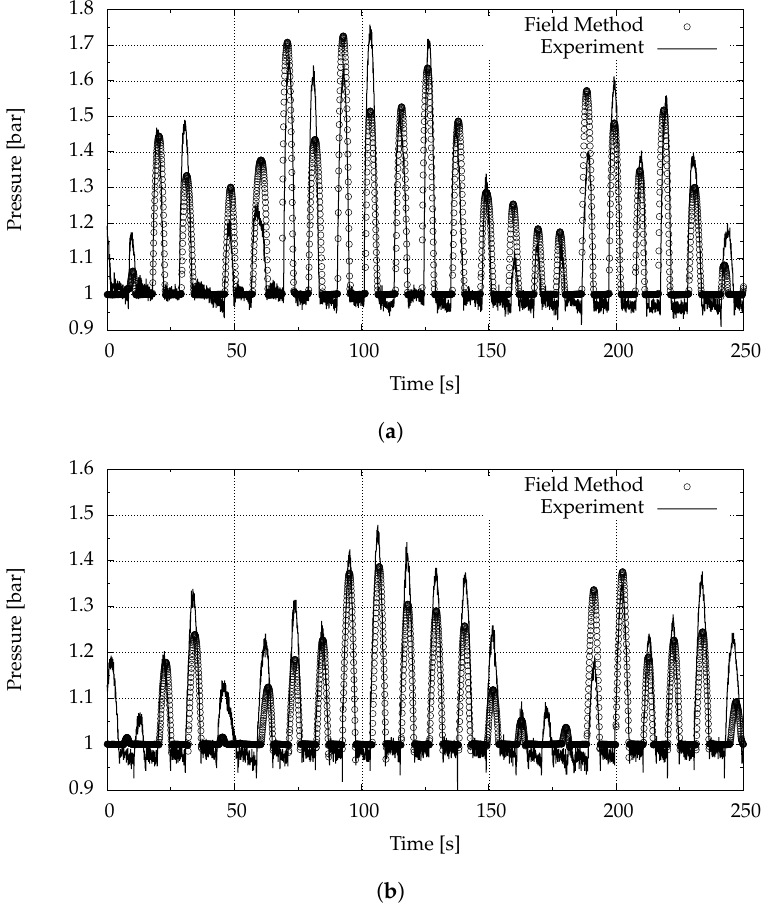
Figure 20. LNG carrier: field method computed time histories of pressures at ( a ) sensor 10 and ( b ) sensor 34.